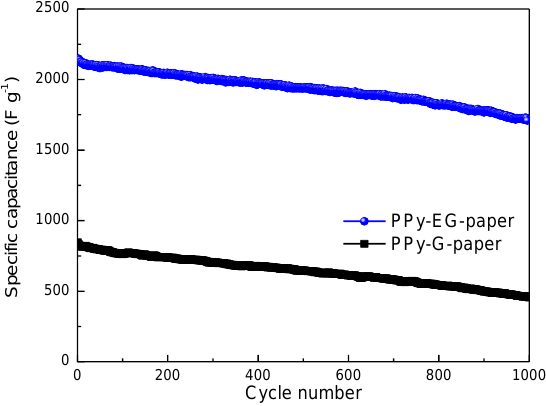
Figure 9. Cycling performance of PPy-G-paper and PPy-EG-paper at a current density of 0.8 mA · cm − 2 .